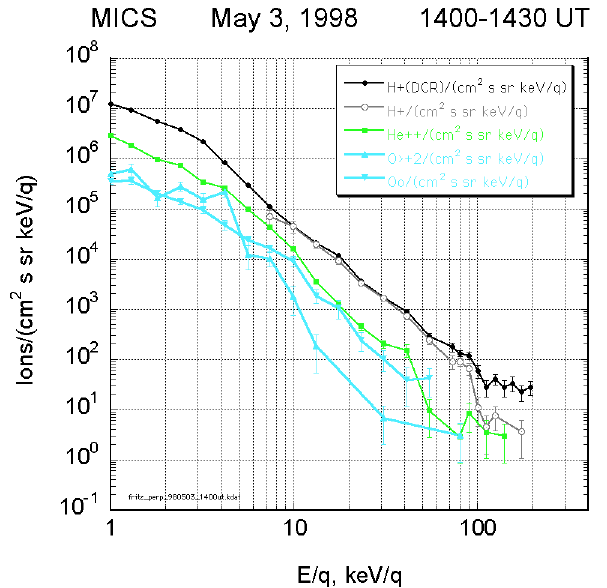
Fig. 12. The energy spectrum of flux versus energy/charge of the four major ion species determined for the interval from 14:00UT to 14:30UT on 3 May 1998.